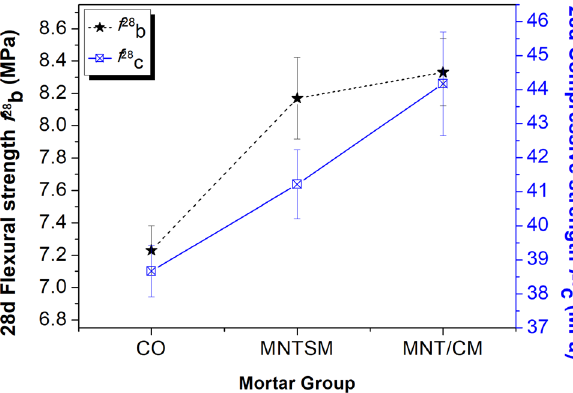
Figure 5: The fl exural and compressive strengths of MNTSM, MNT/ CM, and